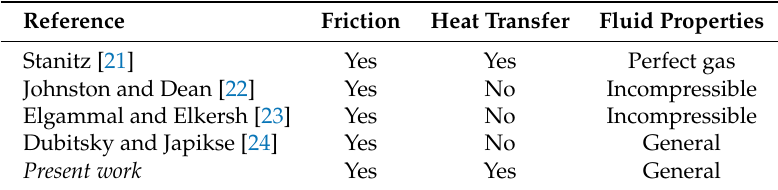
Table 2. One-dimensional diffuser models in the open